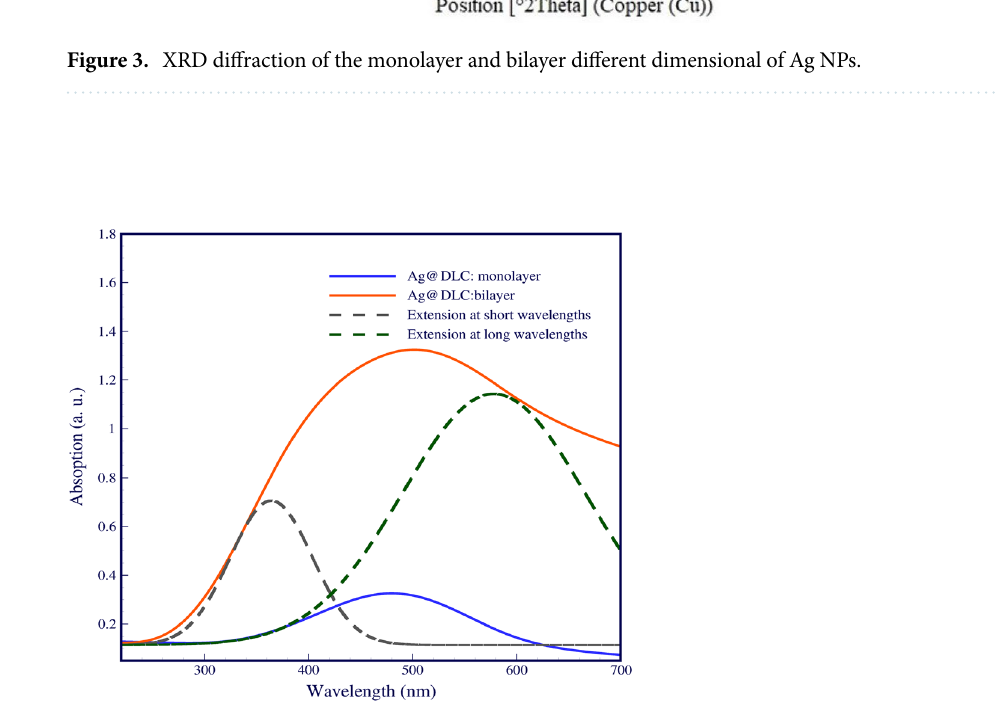
Figure 4. Normalized absorption spectra of the monolayer and bilayer different dimensional of Ag